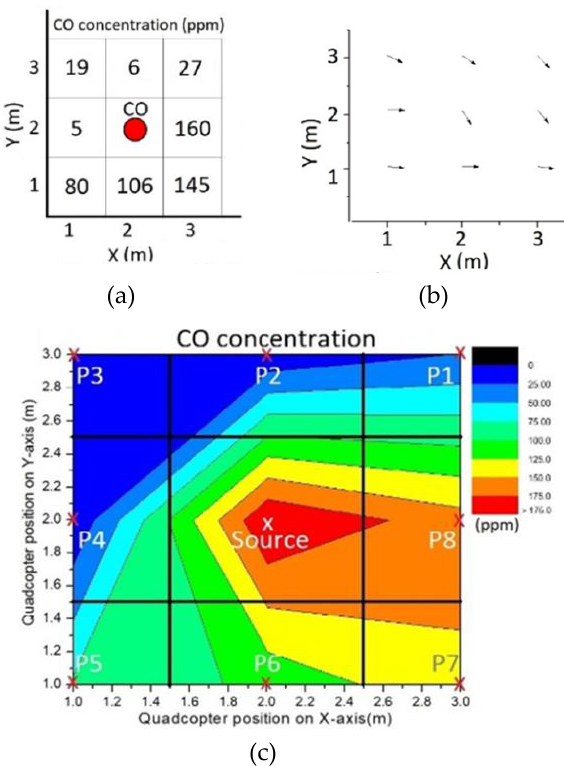
Figure 9. Point source experiment results: ( a ) CO concentrations; ( b ) CO vectors; ( c ) Gas dispersion.